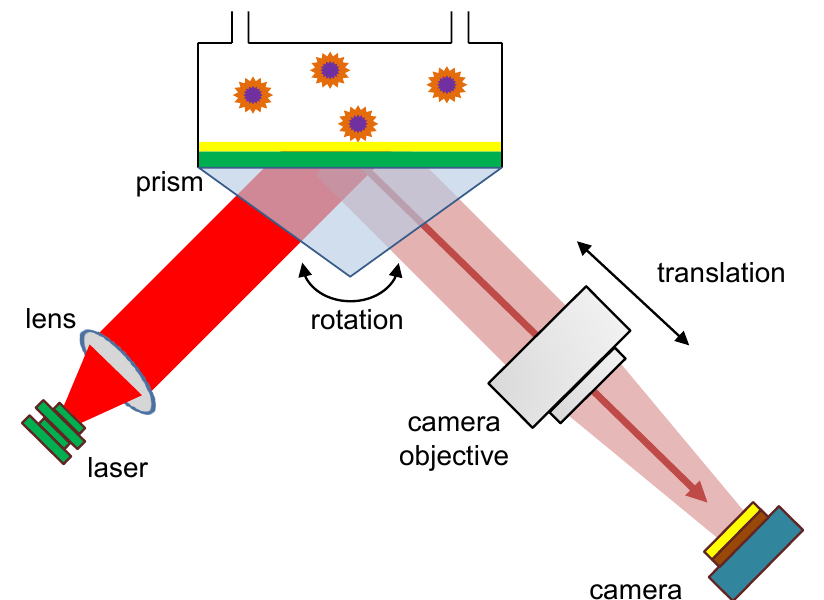
Figure 4. Schematic setup of the primary-version SPR microscopy sensor, including a rotation platform to change the incidence angle of the laser beamed at the prism and a translation platform to move the camera objective. Modified from